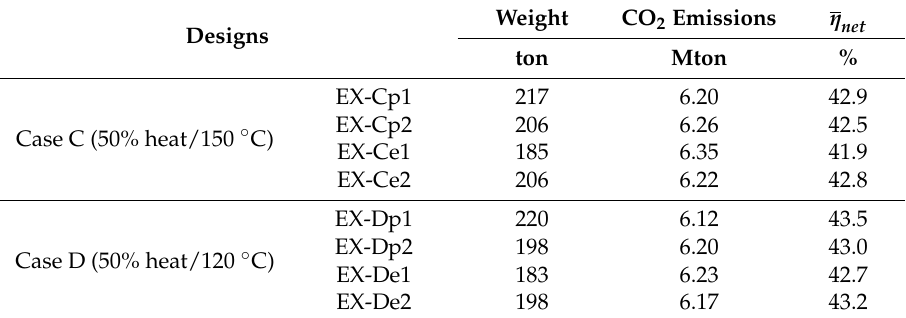
Table 8. Lifetime performance of the designs defined for the extraction steam turbine